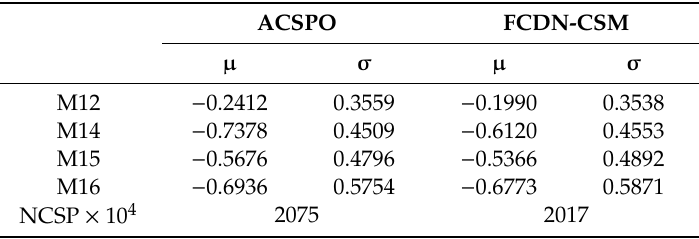
Figure 5. Global distribution of the four CSM types from ACSPO ( left ) and FCDN-CSM ( right ) for NOAA-20. Table 3. Global O-M statistics for NOAA-20 on 11 March 2019. ( µ stands for O-M bias and σ is standard deviation).